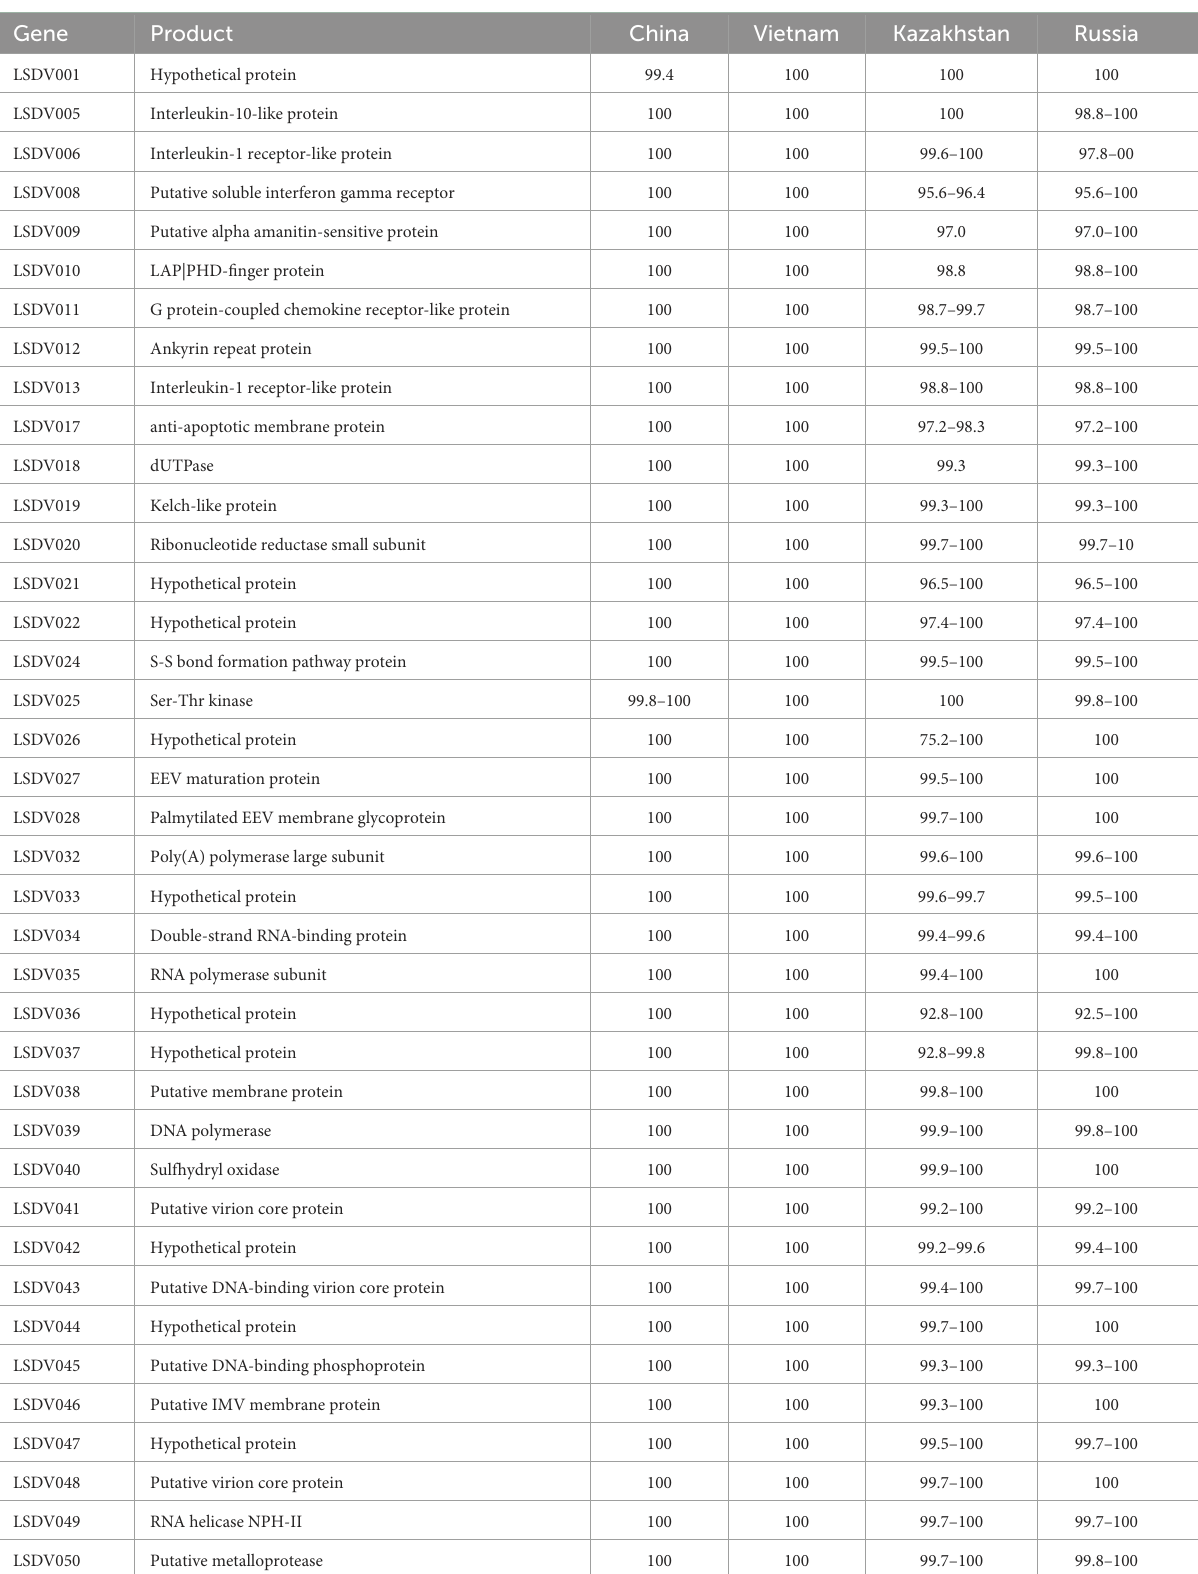
TABLE 1 ORFs that are not identical between LSDV/China/XJ01/2019 and other Chinese, Kazakhstan, Russian and Vietnamese Lumpy skin disease virus strains.